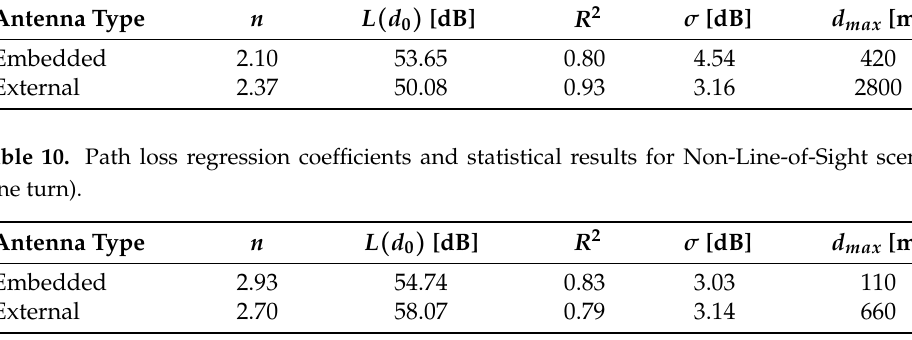
Table 9. Path loss regression coefficients and statistical results for Line-of-Sight scenario